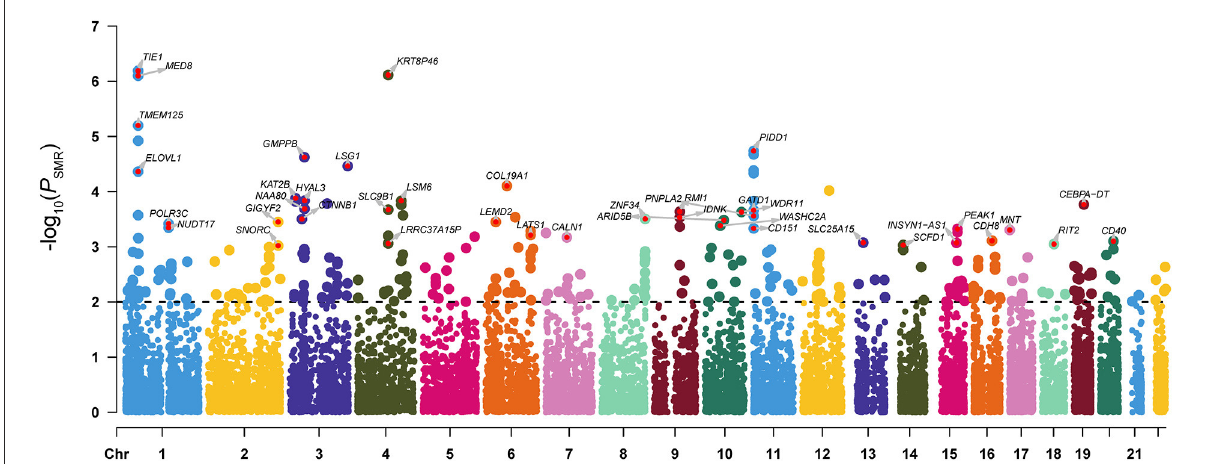
FIGURE1 Manhattan plot of the SMR analysis integrating ADHD GWAS data with the BrainMeta eQTL data. P -value indicates the statistical significance of the SMR analysis results. The dotted line represented the SMR significant threshold ( P SMR < 0.01). For genes with P SMR < 0.001 and P HEIDI > 0.01, we also marked the gene names in the figure.